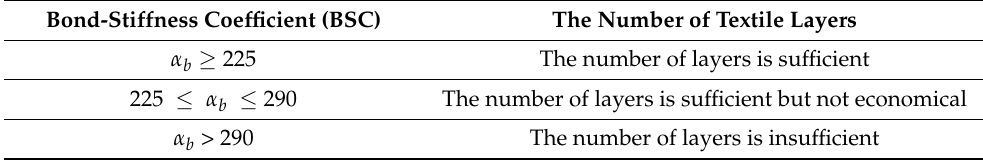
The number of layers is